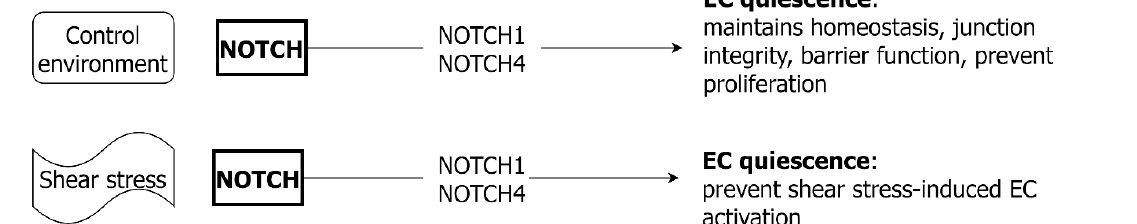
Figure 8. Summary of the mechanisms of NOTCH signaling pathways in EC. Generally, the role of NOTCH signaling in EC is to maintain the quiescent phenotype, particularly suppress shear stress-induced activation.